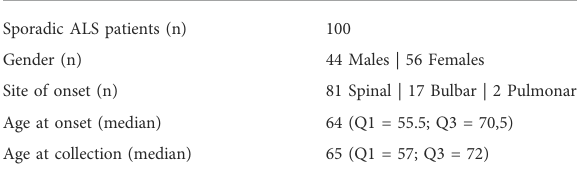
TABLE 1 Clinical features of the ALS